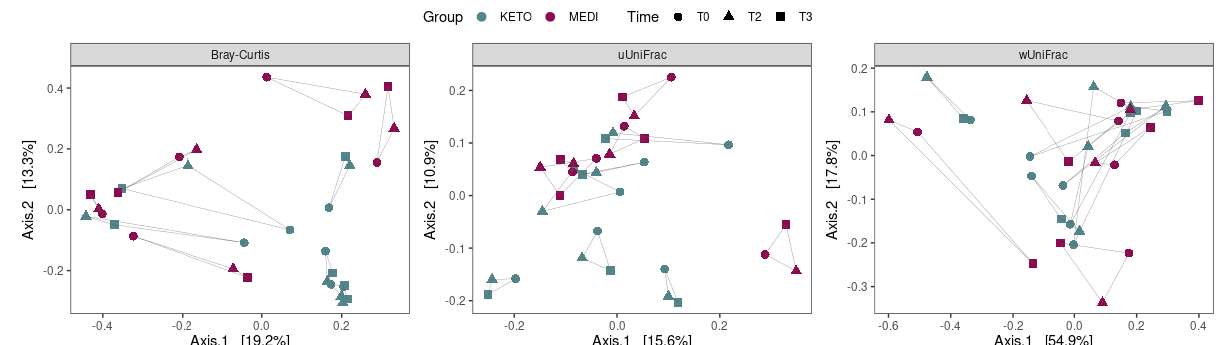
Figure 4. Principal coordinate analysis plots showing gut microbiota compositional changes along time points for each diet. Each subplot concerns a different beta diversity metric (Bray-Curtis, unweighted UniFrac, or weighted UniFrac). Samples from the same patient are linked by a gray line. KETO = 6 patients who followed a very-low-calorie ketogenic diet (VLCKD), MEDI = 5 patients who followed a low-calorie Mediterranean diet (MD). Samples were analyzed at baseline (T0), after two months (T2), and after three months (T3) of nutritional